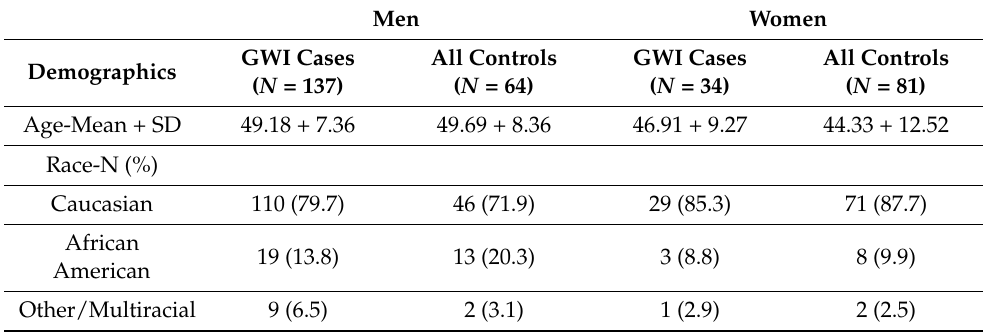
Table 1. Demographics of study